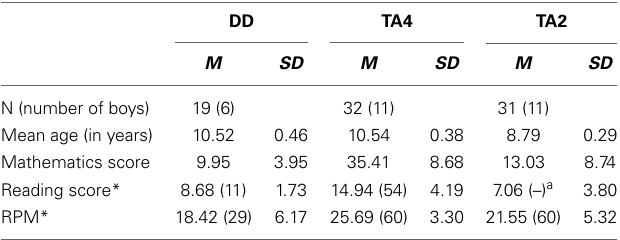
Table 1 | Descriptive participant information by